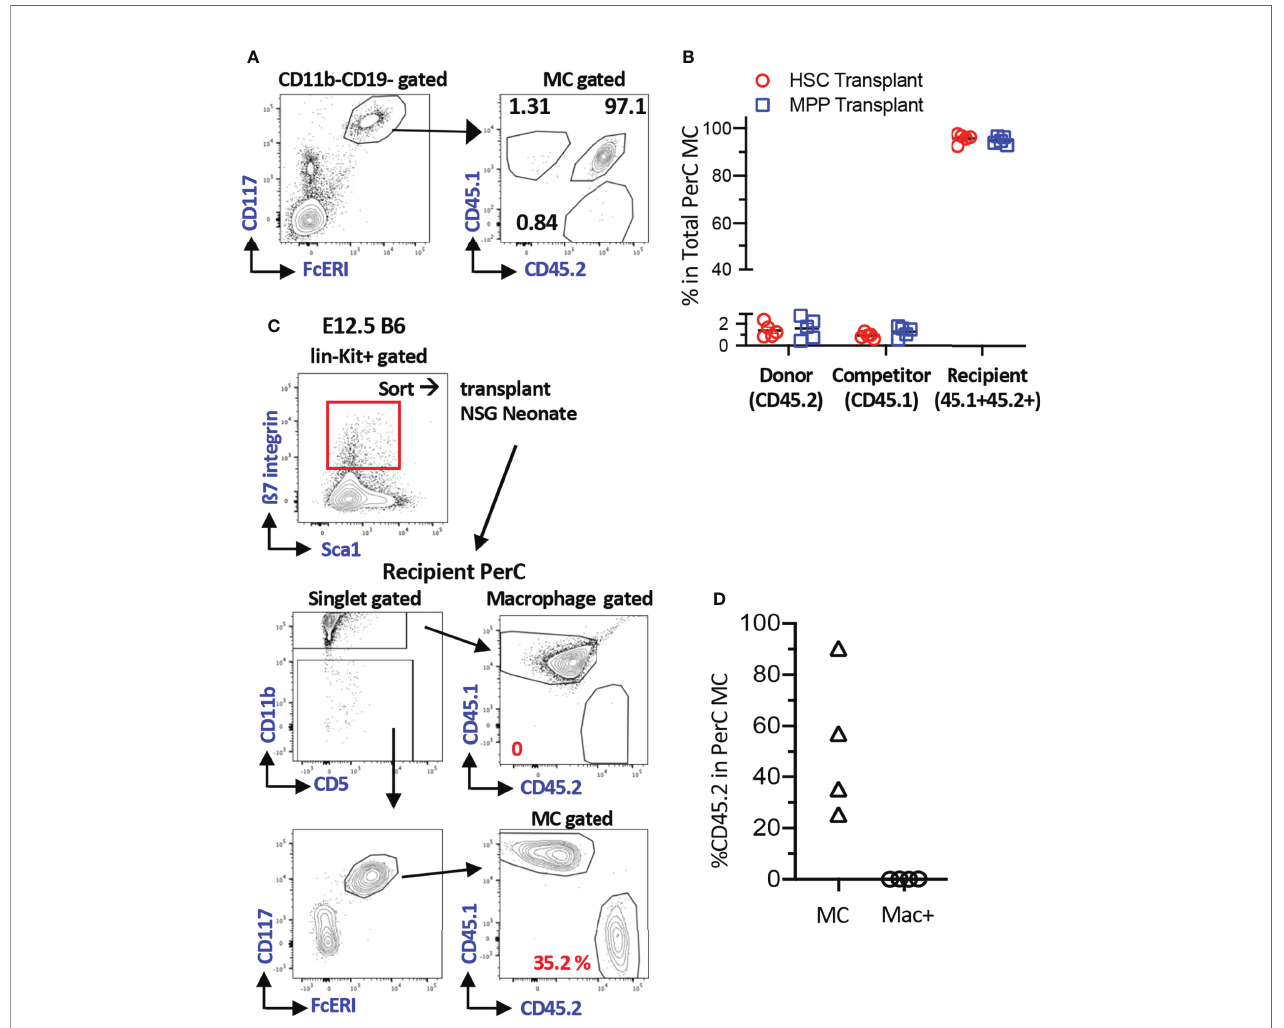
FIGURE 1 | Ef fi cient MC repopulation in neonatal NSG recipient mice. (A) Representative fl ow plots of recipient ’ s PerC cells transplanted with BM HSC cells. Sorted 100 adult BM HSCs or 3000 MPPs (B6; CD45.2) were transplanted into irradiated F1 B6/BoyJ (CD45.1+CD45.2+) mice together with 3x10 5 BoyJ BM MNCs (CD45.1). (B) Percentages of the donor, competitor, and recipient MC chimerism in the recipient ’ s PerC. (n=5 each) (C) A gating strategy for sorting of c-Kit + b 7-integrin + MC progenitor cells from E12.5 B6 FL (Top Panel). Representative gating for MC and macrophage populations in PerC of recipient NSG mice 2 months after transplant with 3500 of Kit + b 7- integrin + cells (bottom panel). (D) % reconstitution of MCs and Macrophages population in PerC of recipient NSG mice as in